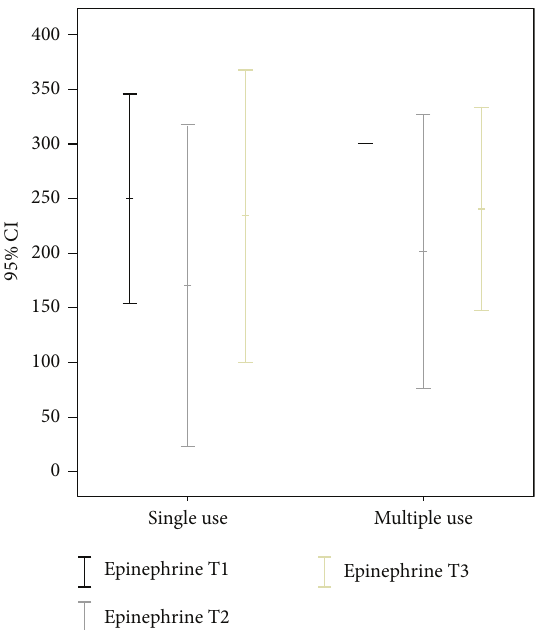
Figure 6: Results of platelet function analysis using adenosine phosphate (ADP) prior to administration (T1), half an hour after administration (T2), and three hours after administration (T3); 𝑦 - axis in